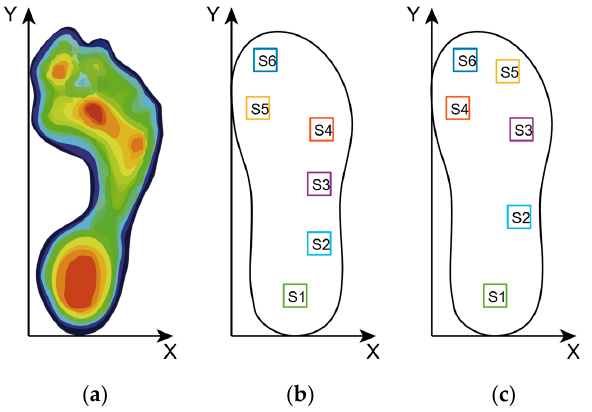
Figure 6. The plantar pressure distribution. ( a )typical plantar pressure distribution in a standing position; ( b ) first insole layout solution; ( c ) second insole layout solution. position; ( b ) first insole layout solution; ( c ) second insole layout